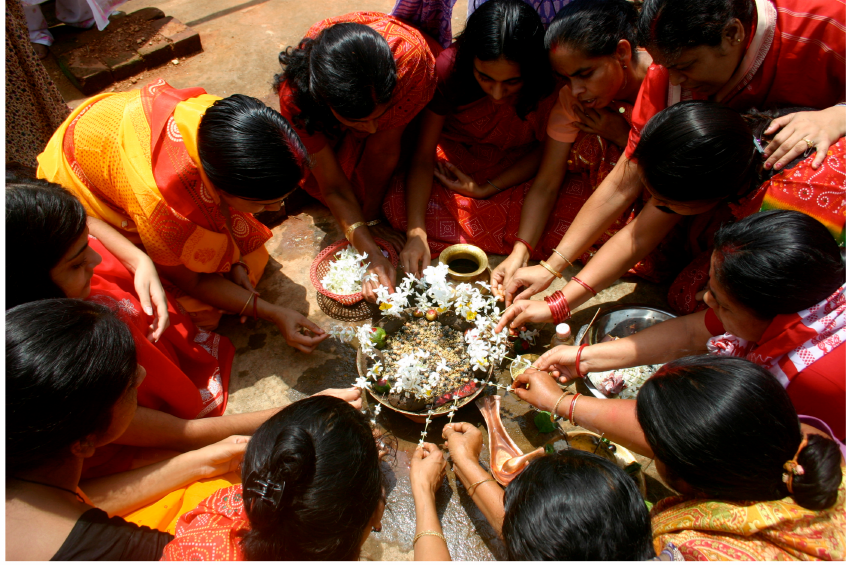
Figure 1. Vegetal icon of the Goddess during x¯ath¯a b r t 10